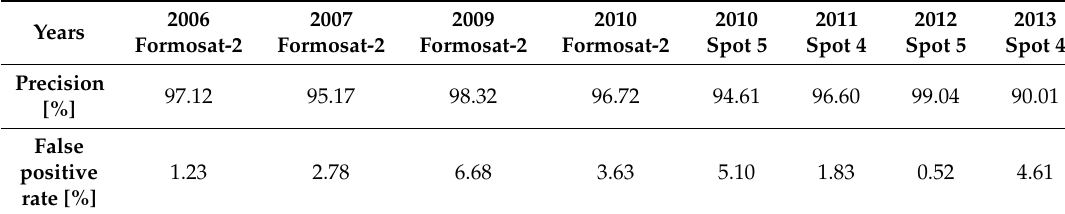
Table 3. Precision [%] and false positive rate [%] for the 7 years.